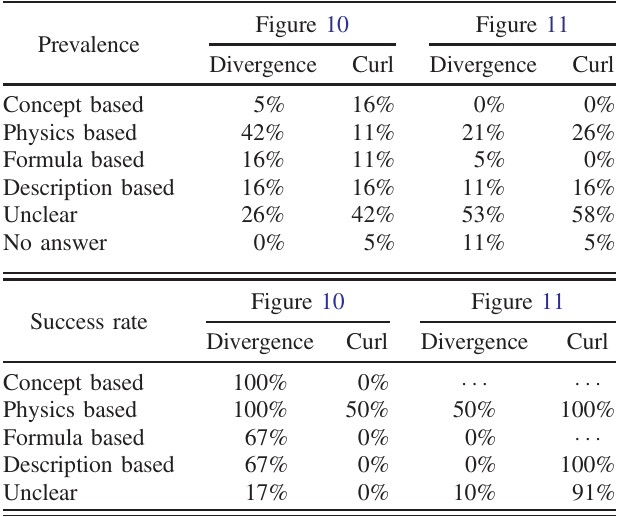
TABLE V. Strategies students used to interpret the divergence and curl of graphical representations of electromagnetic fields in the post-test ð N ¼ 19 Þ